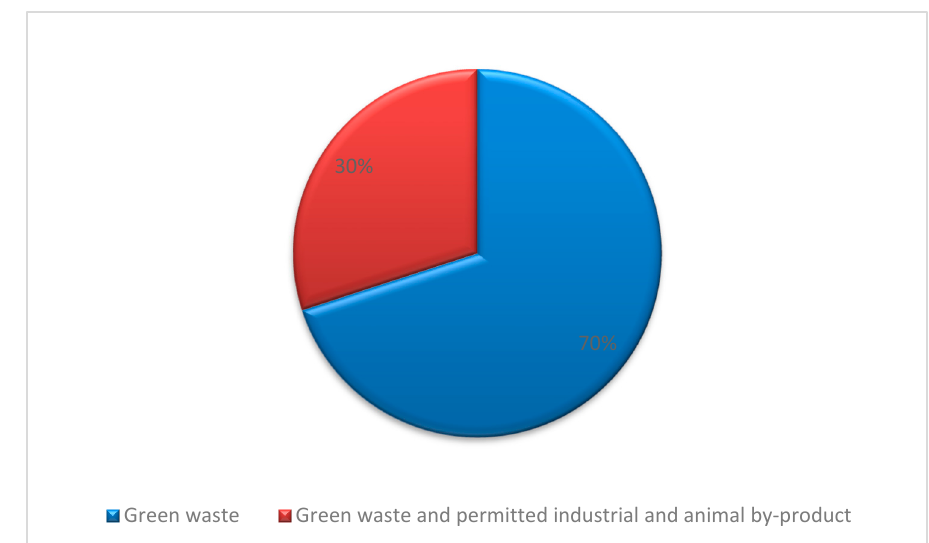
Figure 2. The distribution of certified compost makers throughout the UK; data extracted from Hasznos (2019) shows that the highest number of compost makers are in England as 137 units, Scotland, 23, Wales, 12, and Northern Ireland, 7 [127].